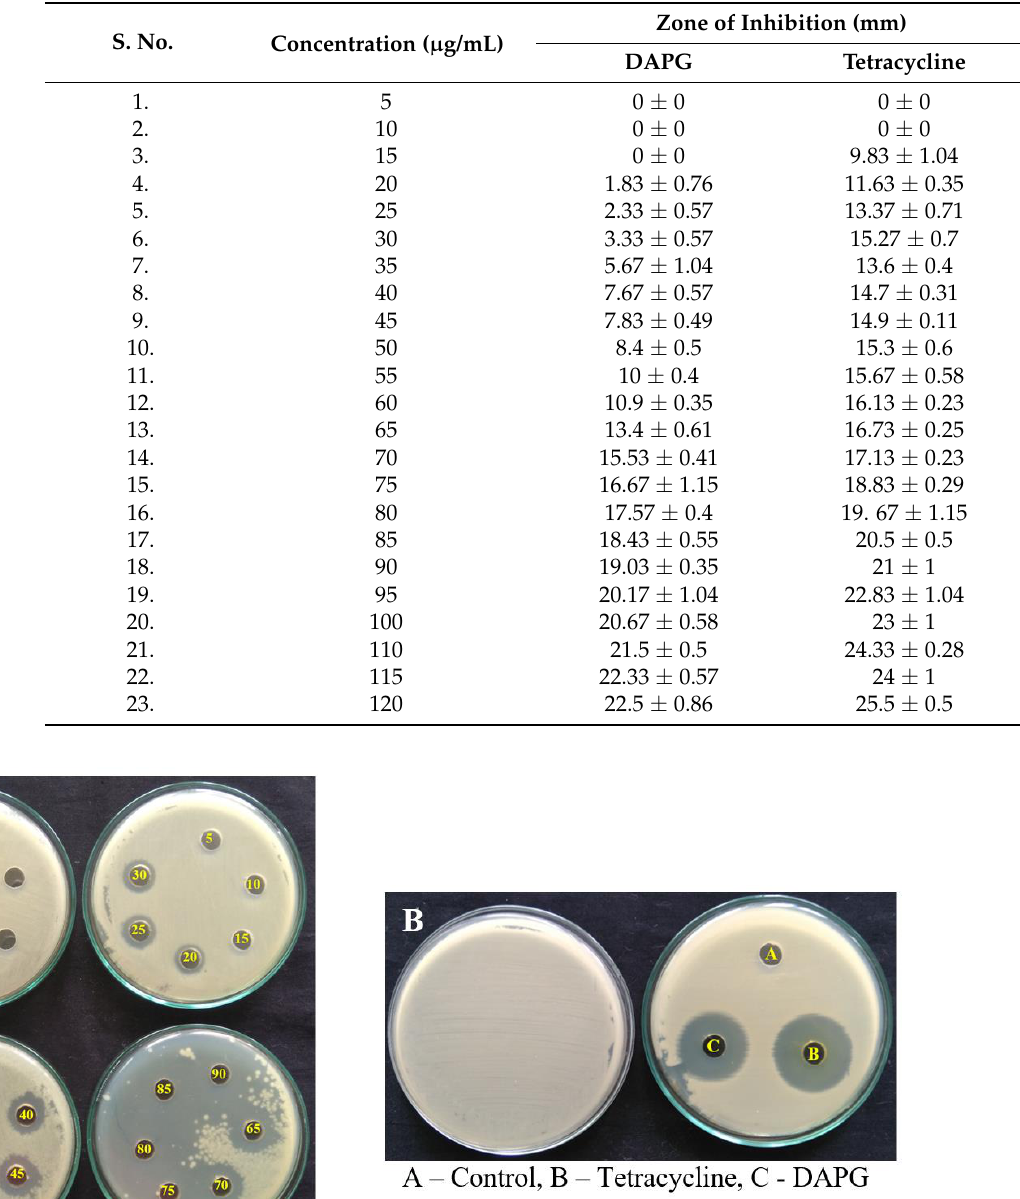
Table 3. Minimum inhibitory concentration of DAPG from P. fluorescens VSMKU3054 against R. solanacearum .